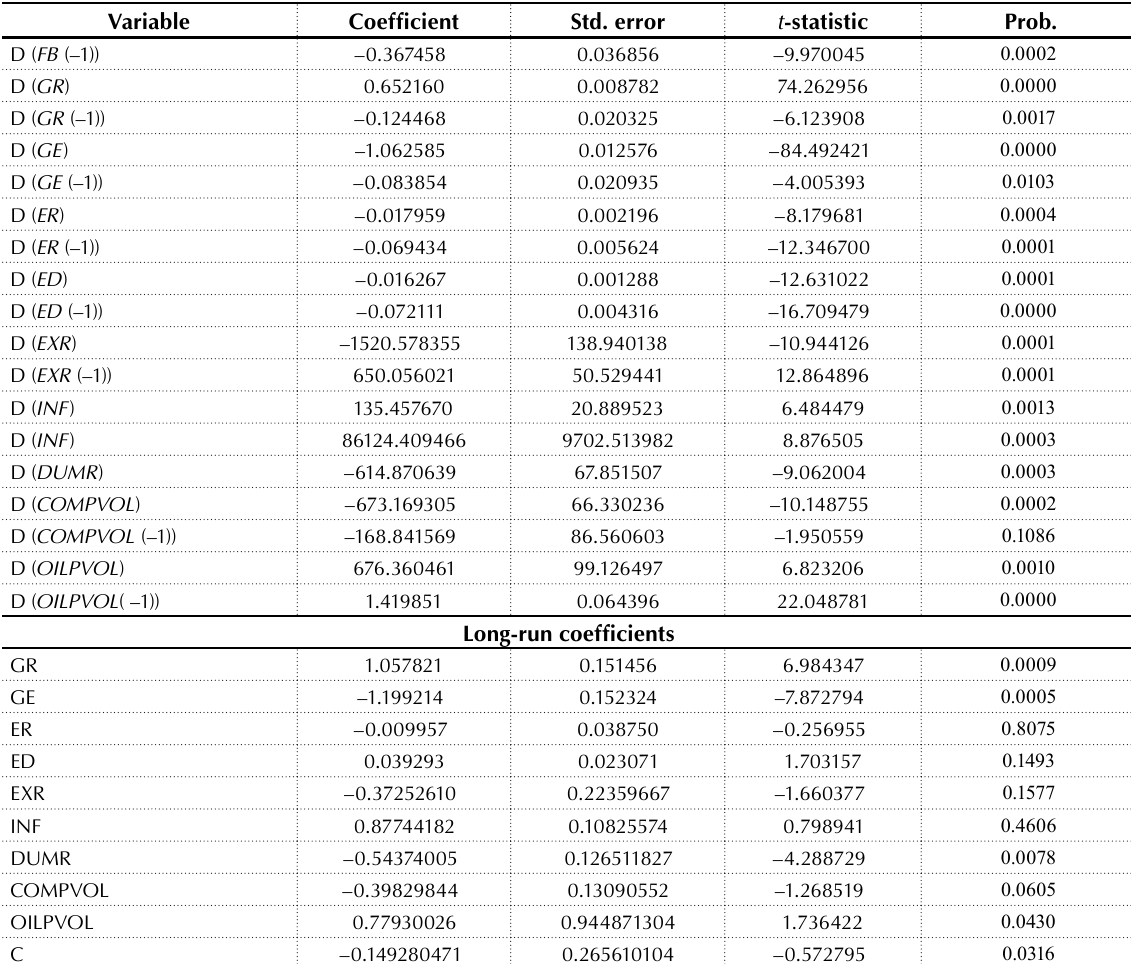
Table 15. ARDL Short-run and long-run forms for fiscal policy shocks and fiscal balance